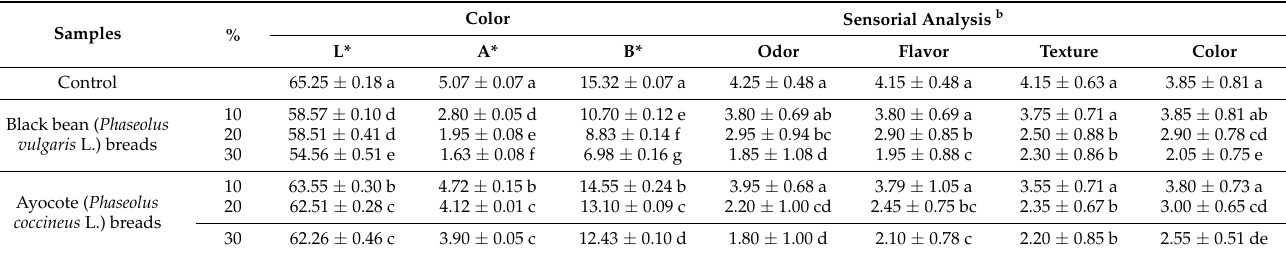
Table 5. Color and sensory evaluation of breads